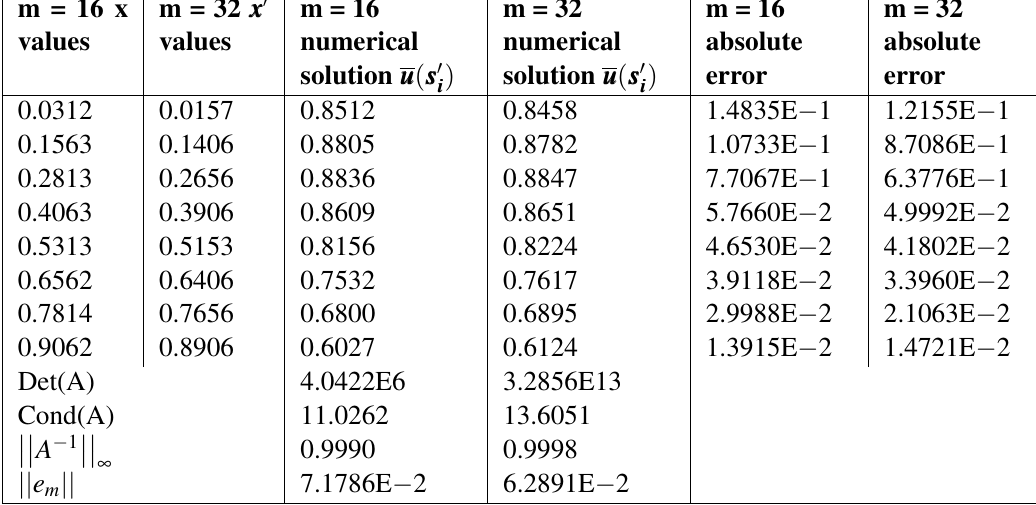
Table 1 The error results of numerical solution of m under two different values when α , m = 1 m = 16 x